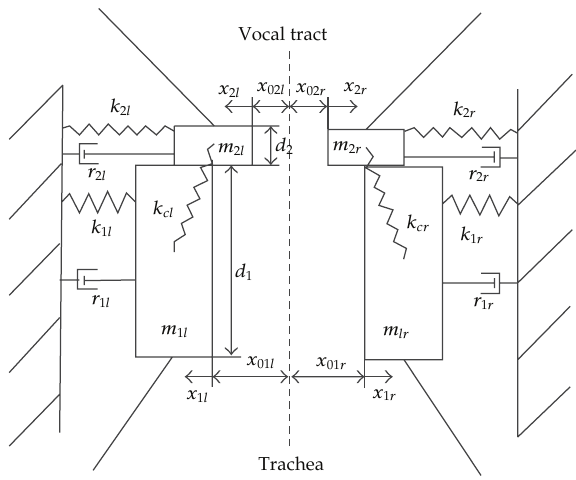
Figure 6: Model of the asymmetric vocal folds (cid:4) 39 (cid:5)